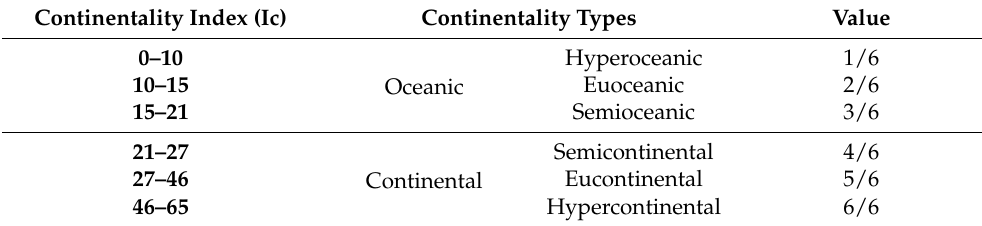
Table A9. Continentality Index assigned values [85].